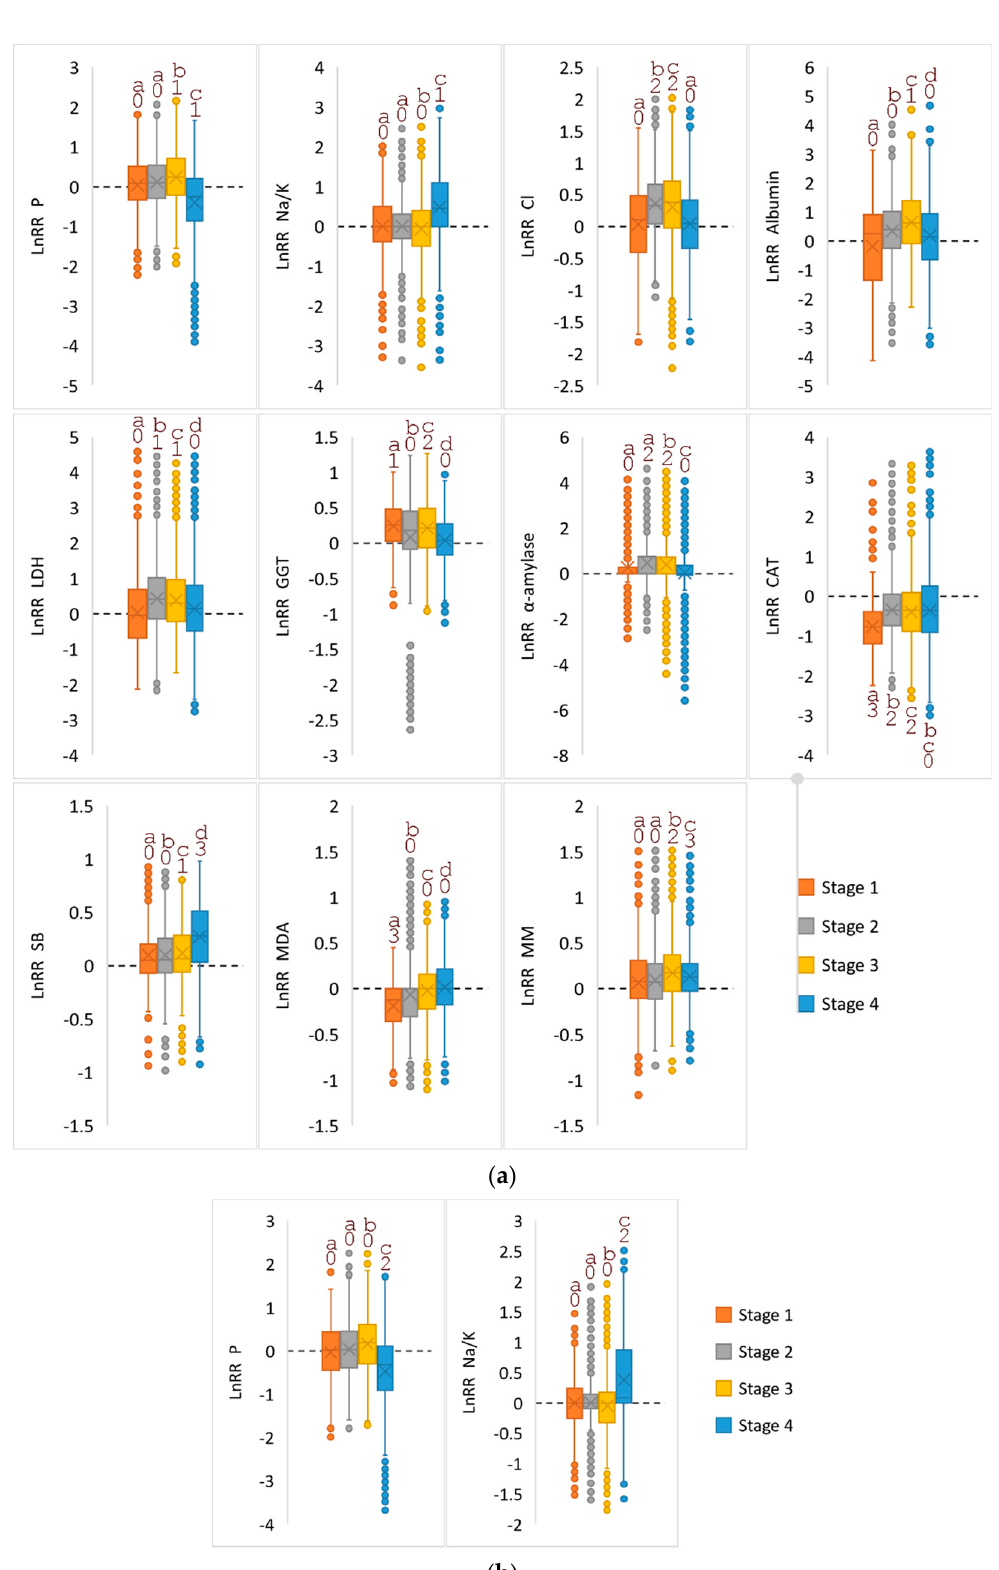
Figure 4. The intensity of the difference Ln RR = Ln (OSCC/Control) for 11 parameters relative to the control group according to stages ( a ) and Ln RR = Ln (OSCC/Comparison) for 2 parameters relative to the comparison group ( b ). Similar letters do not differ much ( α = 0.05). The dashed line represents the zero level ( Ln RR = 0). Significance of differences from 0 was checked using the t-test of one sample and indicated by numbers (“0” is not significant; “1” is p < 0.05; “2” is p < 0.01; “3” is p < 0.001).